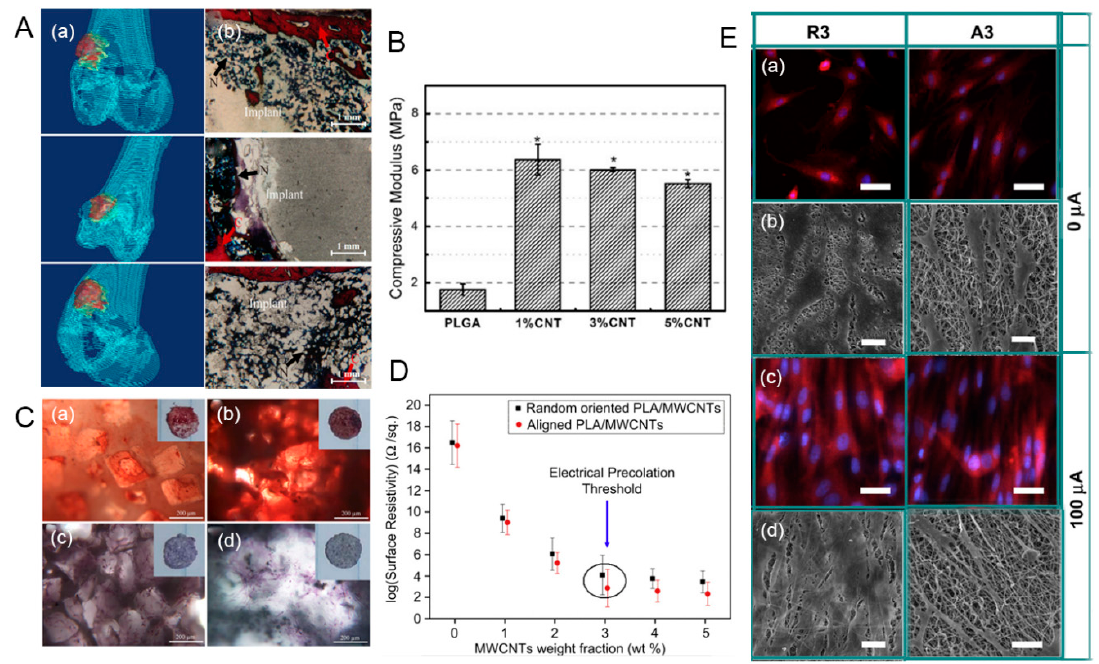
Figure 6. The application of carbon nanotube (CNT)-based polymethyl methacrylate (PMMA) and poly(lactide-co-glycolide) (PLGA) biomaterials for bone regeneration and fracture healing. ( A ) 3D reconstruction of CT images ( a ) and van Gieson-stained images of PMMA–MWCNT bone cement specimens at 12 weeks after implantation ( b ) (collagen fibers: red; nucleus of osteoblast: brown-black). ( B ) Compressive modulus of PLGA and CNT–PLGA scaffolds (* p < 0.05). ( C ) Alizarin red S staining ( a , b ) and alkaline phosphatase (ALP) staining ( c , d ) of MC3T3-E1 osteoblasts on PLGA ( a , c ) and 1% CNT–PLGA scaffolds ( b , d ) at day 21. ( D ) Impact of level of MWCNT loading on the surface resistance of electrospun polylactic acid (PLA)–MWCNT nanofiber meshes. ( E ) Fluorescence microscope images ( a , c ) and selected scanning electron microscope images ( b , d ) of osteoblasts cultured on R3 (randomly oriented PLA fibers with a 3 wt.% ratio of MWCNTs) and A3 (aligned oriented PLA fibers with a 3 wt.% weight ratio of MWCNTs) for 5 and 7 days, respectively. Reproduced with permission from [192,195,199]. Elsevier, 2019, 2013 and 2013.